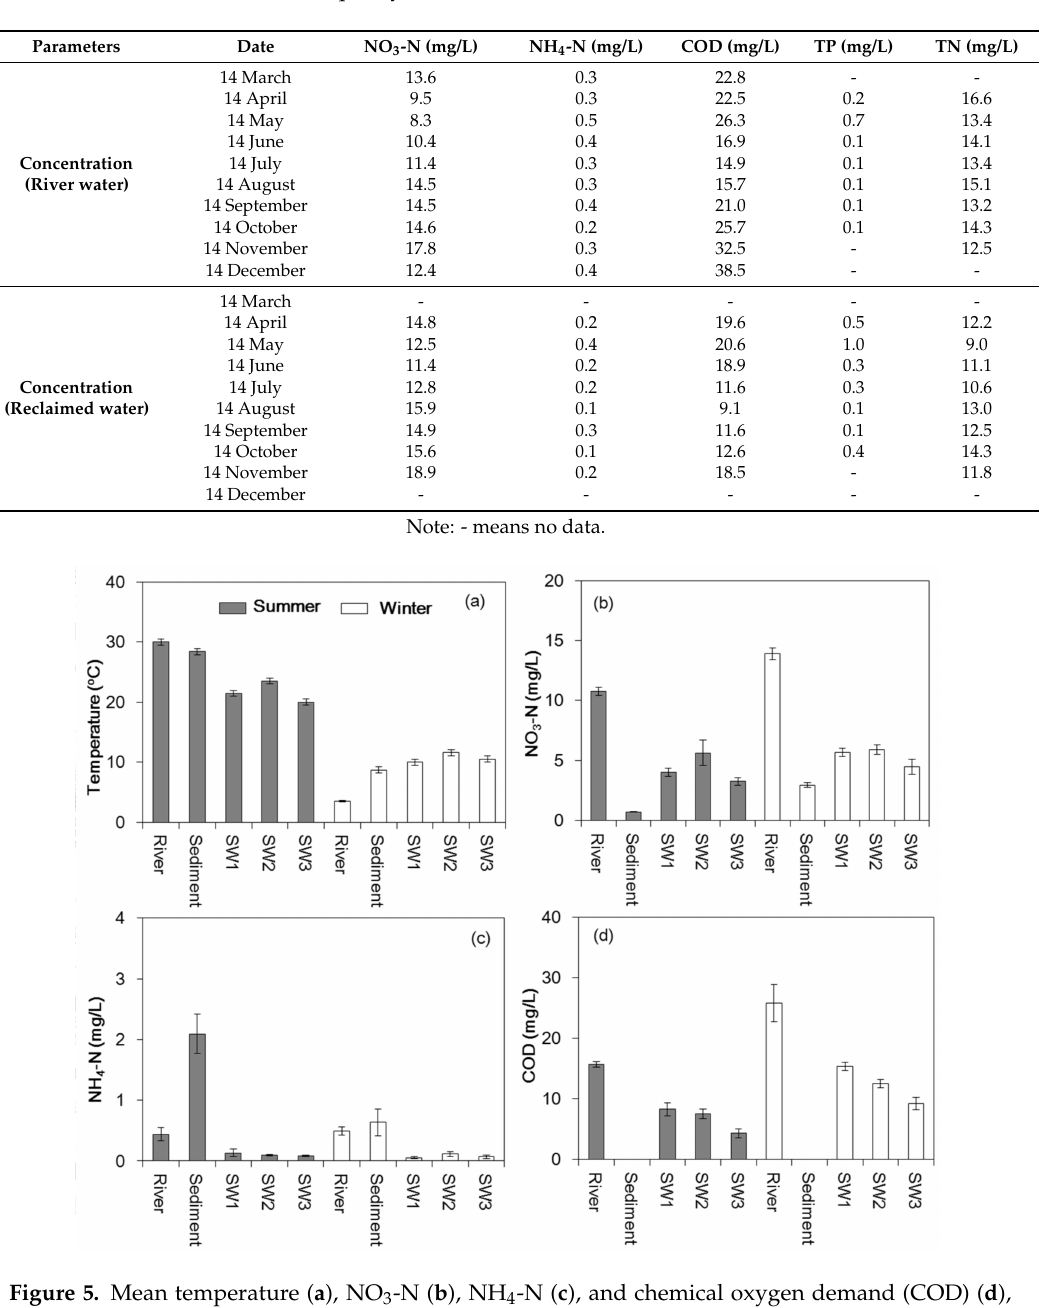
Table 2. Water quality of river water and reclaimed water in 2014.